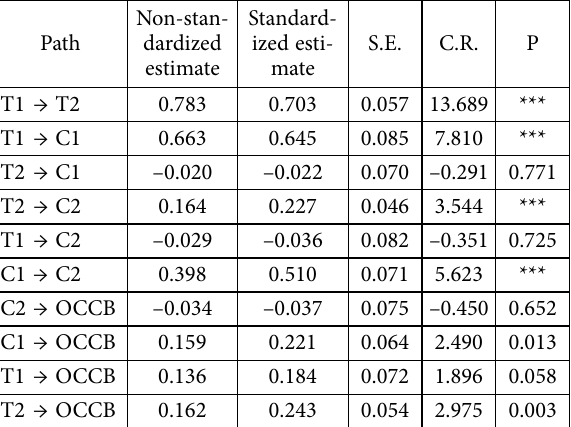
Table 8. Results of hypotheses testing